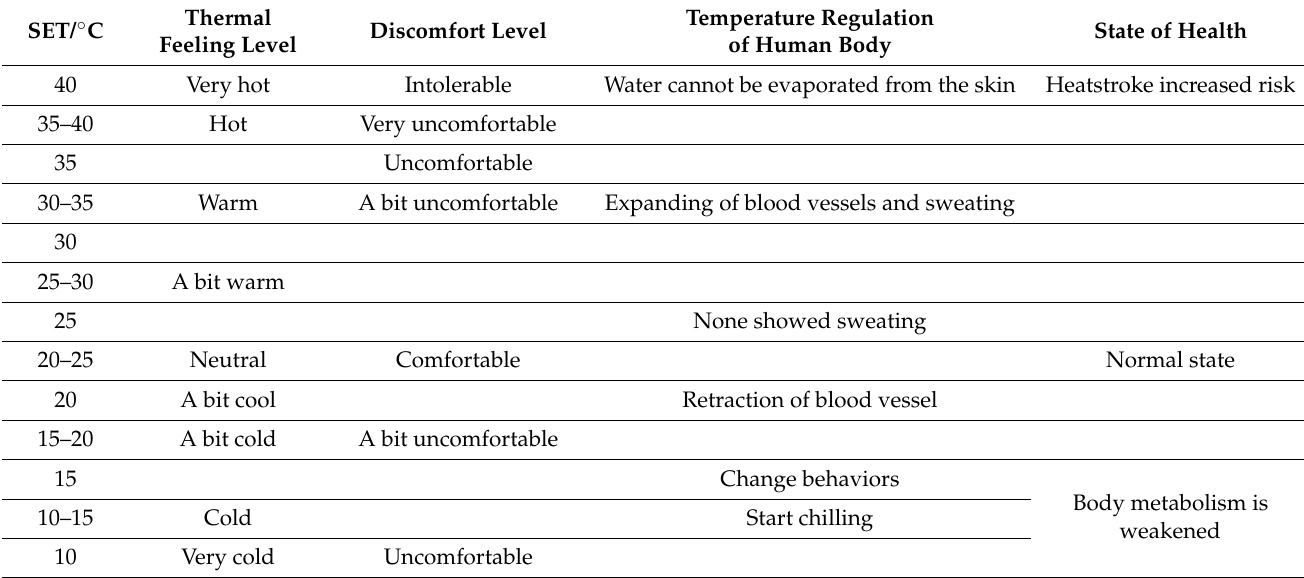
Table 2. Standard effective temperature. Adapted from ref. [23]. 2015, the authors.